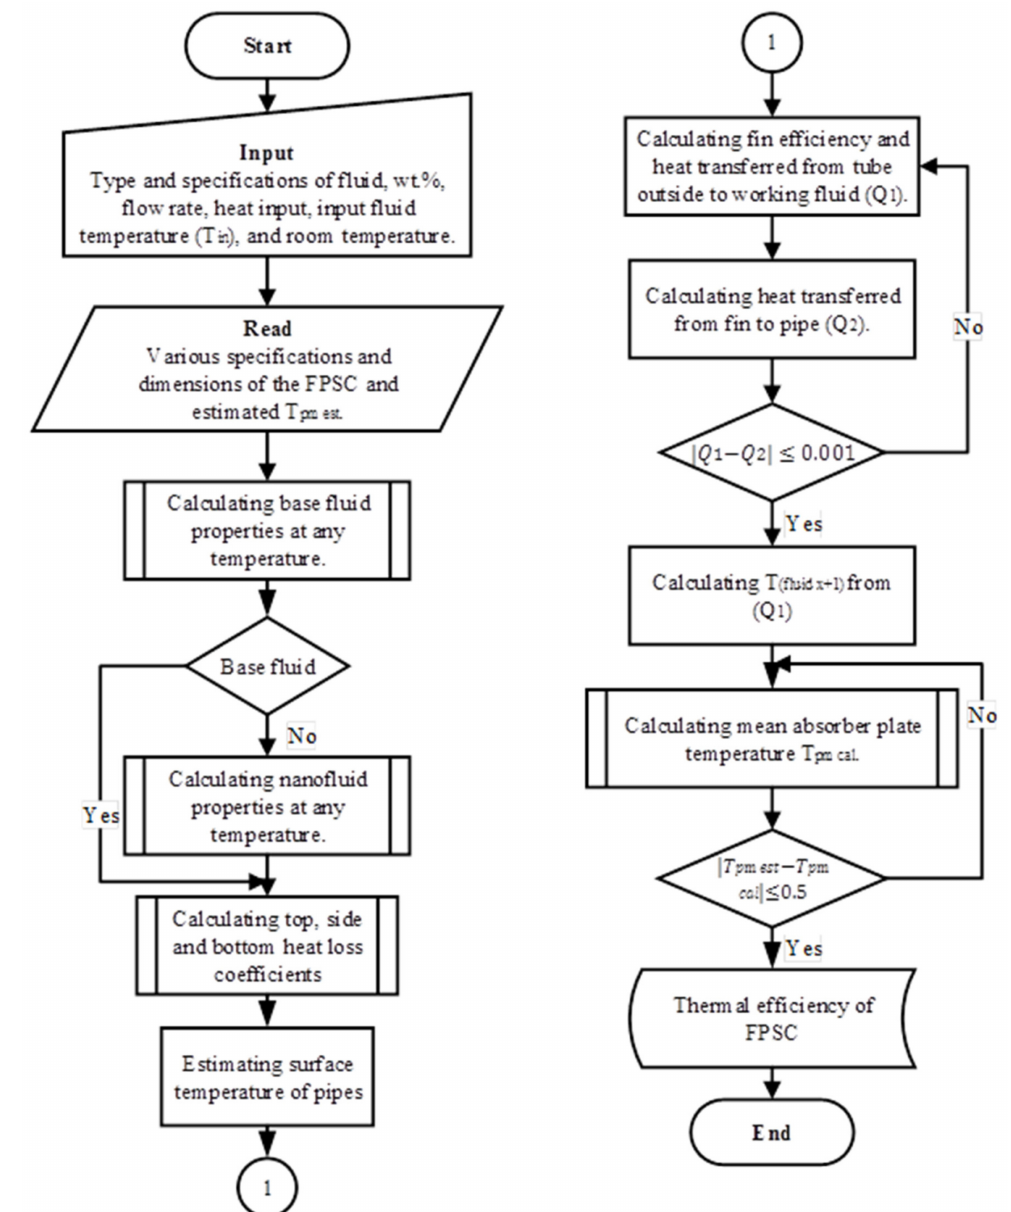
Figure 3. Flowchart of the theoretical model to simulate the nanofluid-based flat plate solar collector (FPSC) in